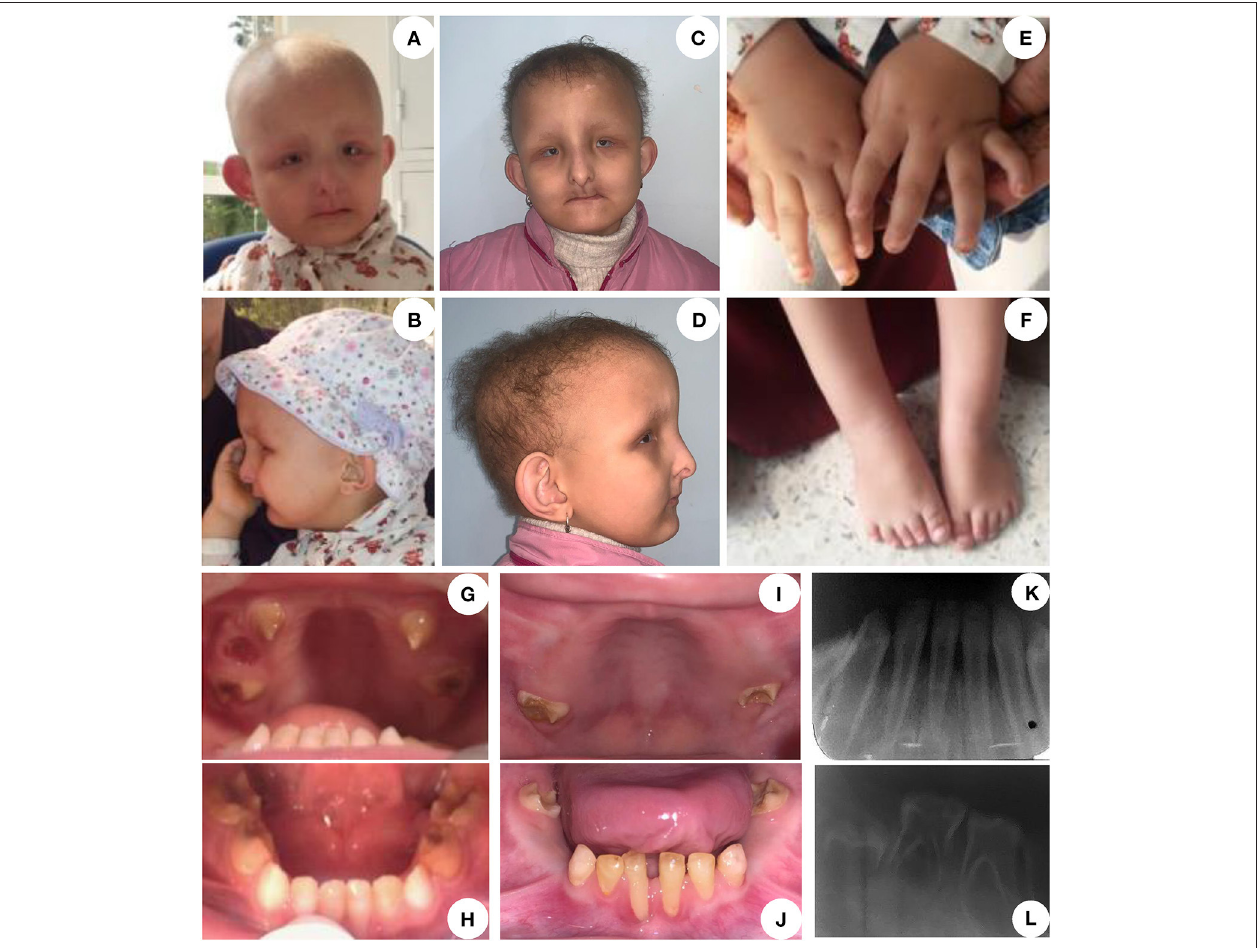
FIGURE 1 | Clinical features of the proband including intraoral examination and x-rays of primary and permanent dentitions. (A,B) First medical visit at 3-year-old. (A) Hypotrichosis, bilateral microphthalmia with nystagmus, hypertelorism. (B) A specific facial gestalt with convex nasal ridge, low set ears and mandibular retrognathia. (C,D) Patient at 6-year-old. Lack of lip support and accentuation of the nasolabial folds due to multiple teeth extractions. (E,F) The patient has brachydactyly, hand bilateral fifth finger clinodactyly, no signs of syndactyly. (G,H) Oral cavity at 3 years old. Primary teeth are affected by a severe form of early childhood caries. Teeth have a brownish yellow color and show significant brittleness of the dental structures. Temporary maxillary canines (G) are thin and conoid. (I,J) Intraoral images at 6-year-old. All primary teeth with dental abscess were extracted. A gingival recession was visible on 81 and 71. (K,L) Intraoral radiographs taken at 3 years of age confirmed hard tissue defects, thin dentin walls, short roots with gaping apices and large pulps giving the appearance of phantom